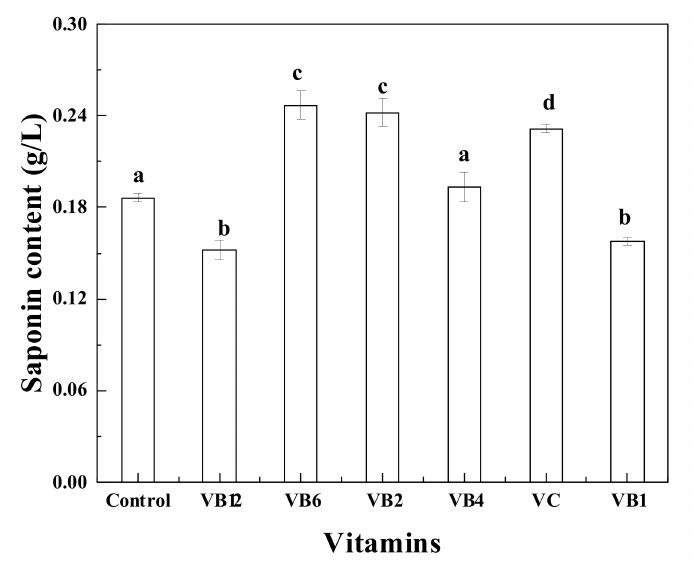
Figure 4. Effects of different vitamins on the saponin production of T. melanosporum . (Different letters on the top of column indicate significant differences between means: a, b, c, d, p <